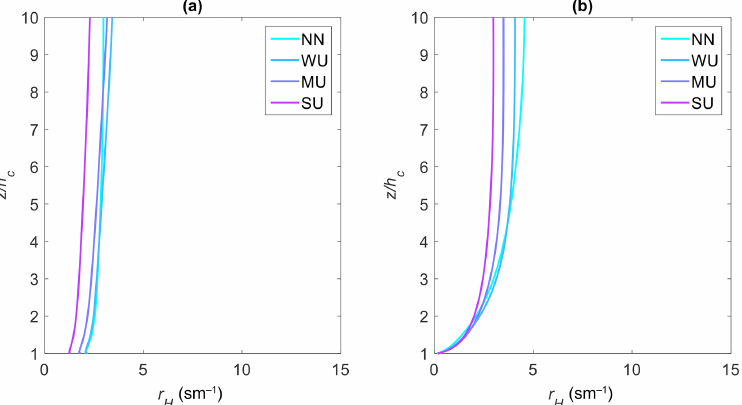
Figure 7. (a) The variation of r H with height across stability according to the improved formulation as modeled by Eq. (13), but using the top-of-canopy surface flux throughout all heights; (b) similar variations of r H computed from the LES using the top-of-canopy surface flux assumed to be constant in the surface